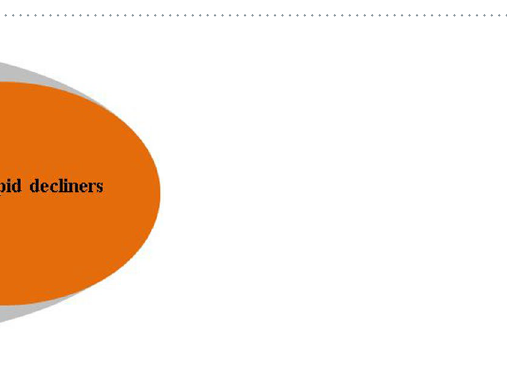
Table 2. Correlations between biomarkers and clinical data for all MCI subjects. Baseline = baseline clinical data; Slope = rate of change of clinical data. The correlations between biomarker data and baseline clinical data are weaker than those with the rate of change of clinical data.